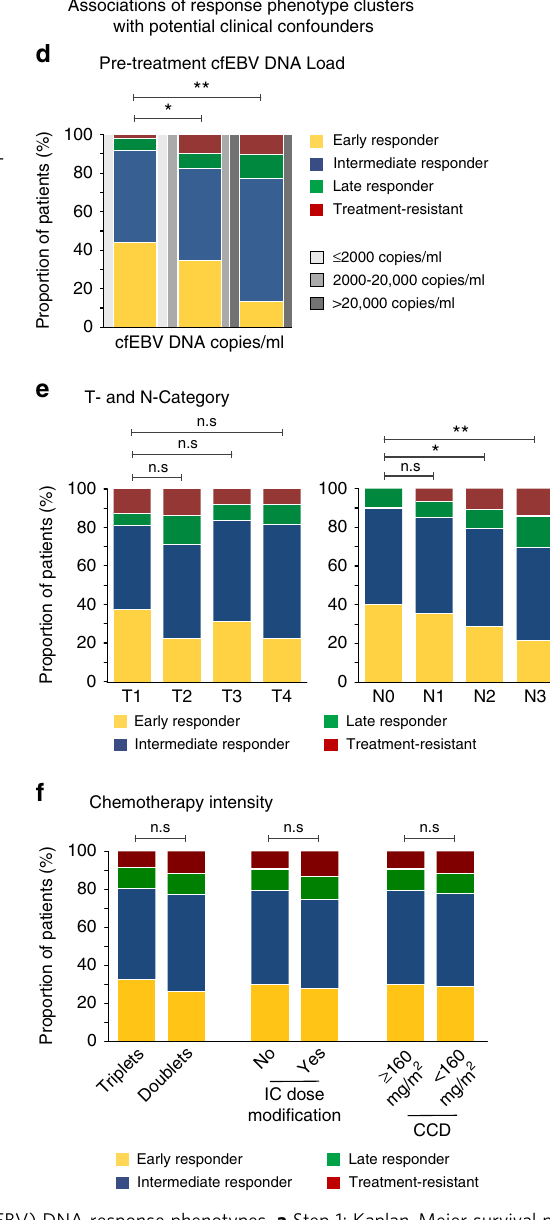
Fig. 3 Survival clustering analyses of the different cell-free Epstein – Barr virus (cfEBV) DNA response phenotypes. a Step 1: Kaplan – Meier survival plot of disease-free survival (DFS) for the eight cfEBV DNA response phenotypes. b Step 2: Eight subgroups are then ordered in ascending numerical order and clustered by their intergroup hazard ratio (HR) DFS . HRs were represented by the size of circle and categorised by steps of 5.0; P values were represented in grey scale. We derived the following clusters: Cluster 1 — G1, as G1 was signi fi cantly different from G2 – 8. Cluster 2 — G2, G3, G4, G6, as G2 – 4 and G6 were not signi fi cantly different between them, except between G6 and G2. Cluster 3 — G5, as G5 was signi fi cantly different from G1 – 4 and G8. Cluster 4 — G7 and G8, as both groups were signi fi cantly different with G1 – 4, G6, except between G5 and G7. The clustering plot was done using ggplot2 package on R . c Step 3: Kaplan – Meier plot of DFS for the four phenotypic clusters. d Association of the phenotypes with pretreatment cfEBV DNA levels. e Association of the phenotypes with T and N categories, and f association of the phenotypes with chemotherapy intensity. cfEBV DNA levels were strati fi ed based on previously reported cut-offs of ≤ 2000, >2000 – 20,000 and >20,000 harbour truncal genetic mutations that confer sensitivity to taxane, mechanisms. Thus a suboptimal response to IC may not neces- fl uoropyrimidine, gemcitabine and/or platinum chemotherapy. sarily imply resistance to CCRT. In the same vein, we recorded However, this is followed by a delayed and slower rate of clearance occurrences of cfEBV DNA bounces during the IC and CCRT over time, which supports our hypothesis that detectable bio- treatment phases, which had contrasting downstream implications; marker post-IC 1 may re fl ect residual tumour clones that are early bounces were mostly transient and likely to achieve cBR resistant to therapies. Next, the differential responses to IC and following CCRT, while delayed bounces were less likely to resolve CCRT among intermediate and late responders (e.g. non-cBR to and are indicative of early therapeutic resistance. Collectively, this IC but cBR to CCRT) suggest that tumour marker clearance and two previous studies 17,18 highlight the prognostic signi fi cance of cfEBV DNA clearance at various time points during treatment. during IC and CCRT are likely contributed by independent